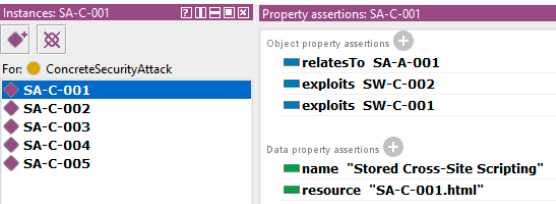
Figure 8. The objective property and data property of concrete knowledge (Security Attack).